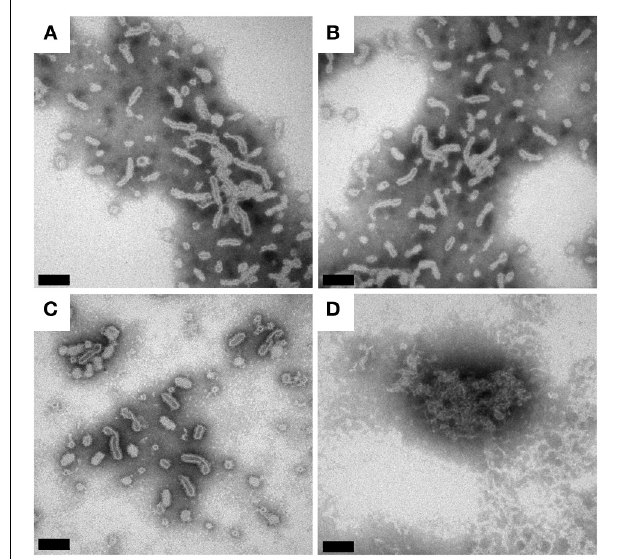
FIGURE 2 | Transmission electron micrographs of BmrA in B. subtilis lipids and EPC/EPA (9:1). The protein reconstituted into a lipid bilayer forms ring- and tubular structures (Orelle et al., 2008). (A) BmrA in B. subtilis lipids 1 day after dialysis. (B) BmrA in B. subtilis lipids 15 days after dialysis (stored at room temperature). (C) BmrA in EPC/EPA 1 day after dialysis. (D) BmrA in EPC/EPA 15 days after dialysis (stored at room temperature), showing the loss of the tubular structure and protein aggregation indicating that, in contrast to the sample in native lipids, the sample is not stable in EPC/EPA for long-term storage. The samples were negatively stained with 2% phosphotungstic acid. The bars represent 100nm (A–C) and 50nm (D)